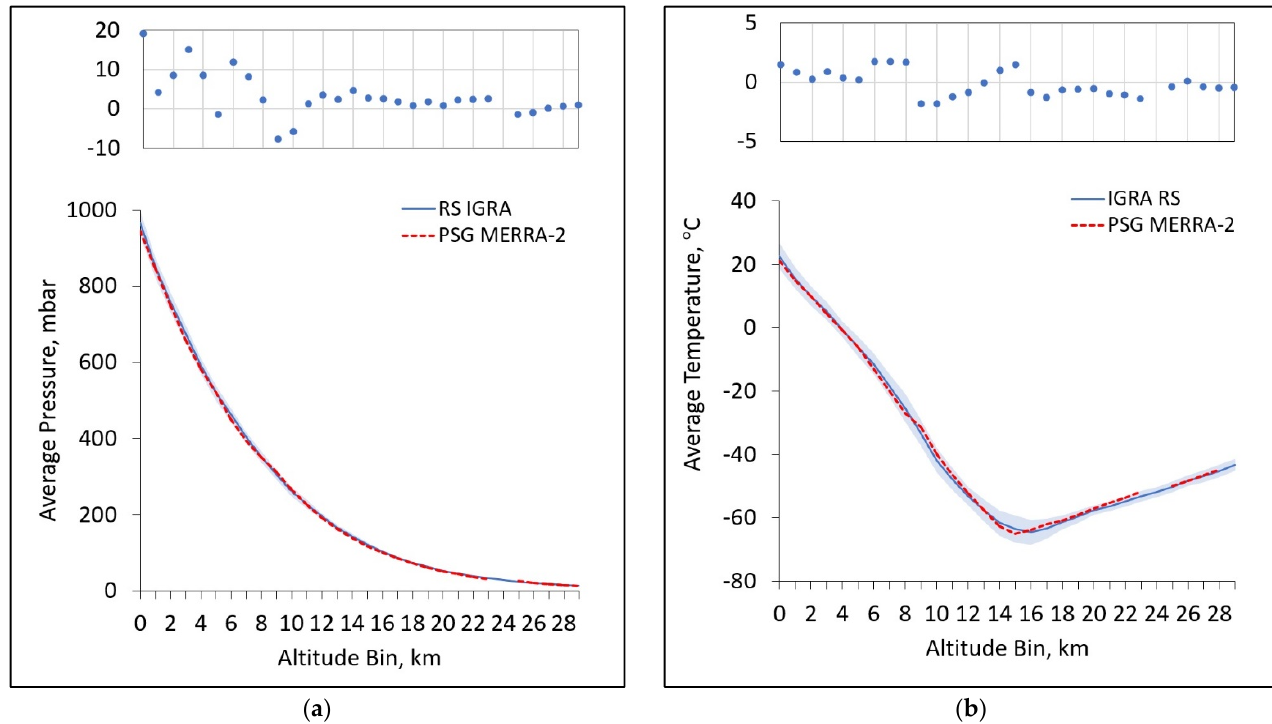
Figure 8. A comparison of the average ( a ) pressure vertical profile and ( b ) average temperature vertical profile for our decade-long, 7-day window with standard deviations shown as a blue shaded region and MERRA-2 reanalysis temperature profiles as red dashed lines. Note that MERRA-2 data were only extracted over a decade-long, 1-day window for 29 July 2010–2020. Residuals in the top panels of each figure show the difference between average IGRA values and average MERRA-2 values.